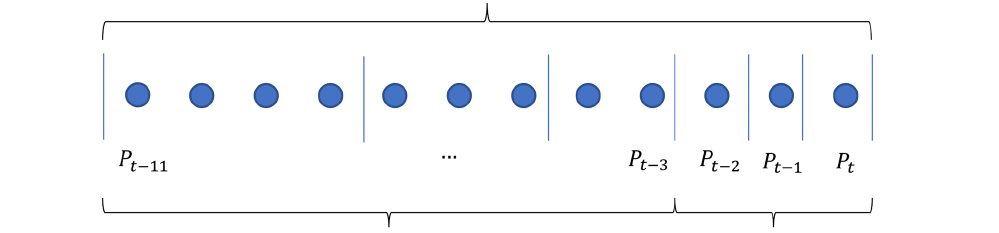
Figure 2. Illustration of the method to place cut points along the time axis.